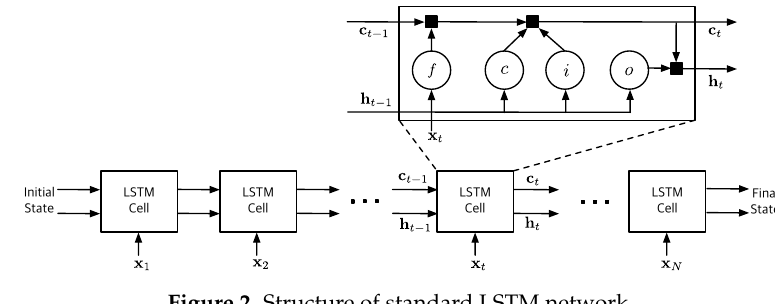
Figure 2. Structure of standard LSTM